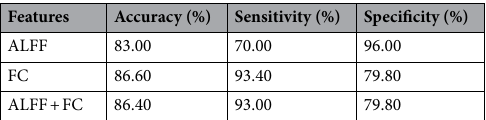
Table 2. Classification results of CI-HC.